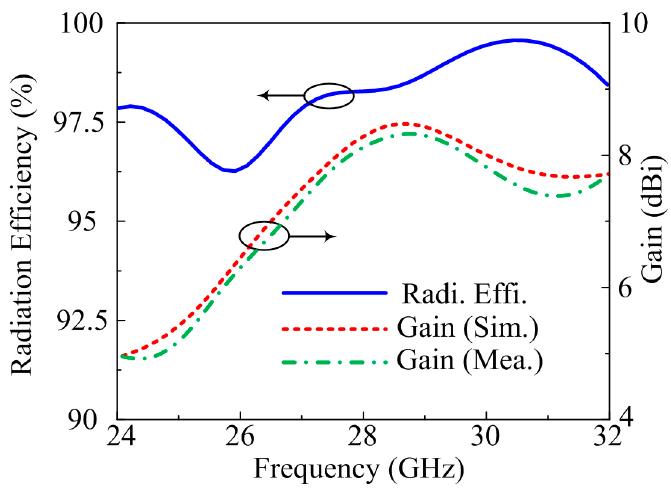
Figure 17. Comparison among gain and numerically calculated radiation efficiency of MIMO antenna with inverted structure placement of element.